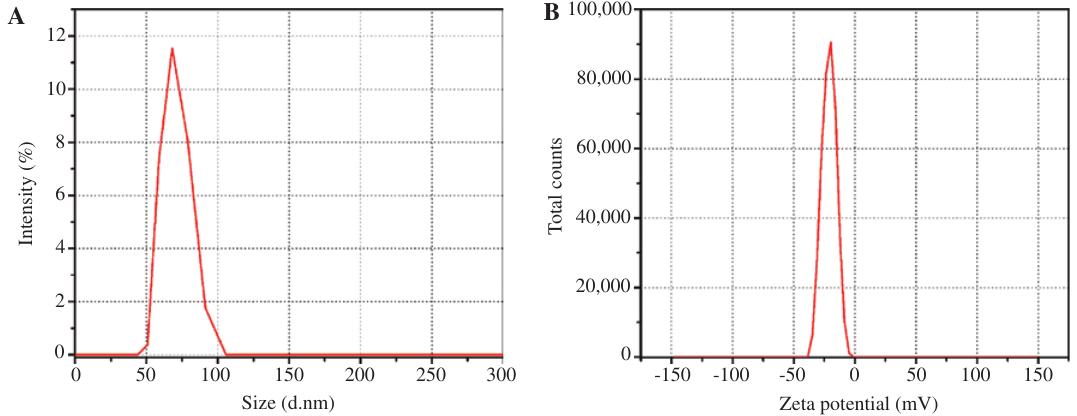
Figure 9: Hydrodynamic size distributions of zinc sulfide nanoparticles with an average hydrodynamic radius of 68 nm as measured by dynamic light scattering (DLS) (A); zeta potential of zinc sulfide nanoparticles synthesized using Chlamydomonas reinhardtii cell free extract (B).